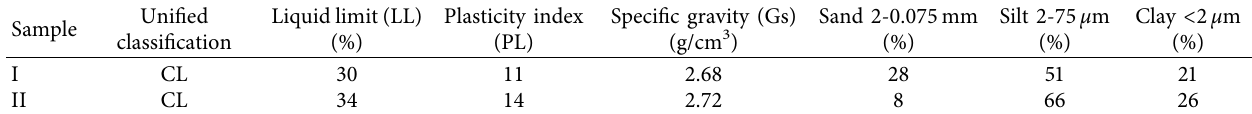
Figure 2: The mechanism of simple shear Table 1: Specifications of the soil specimens.